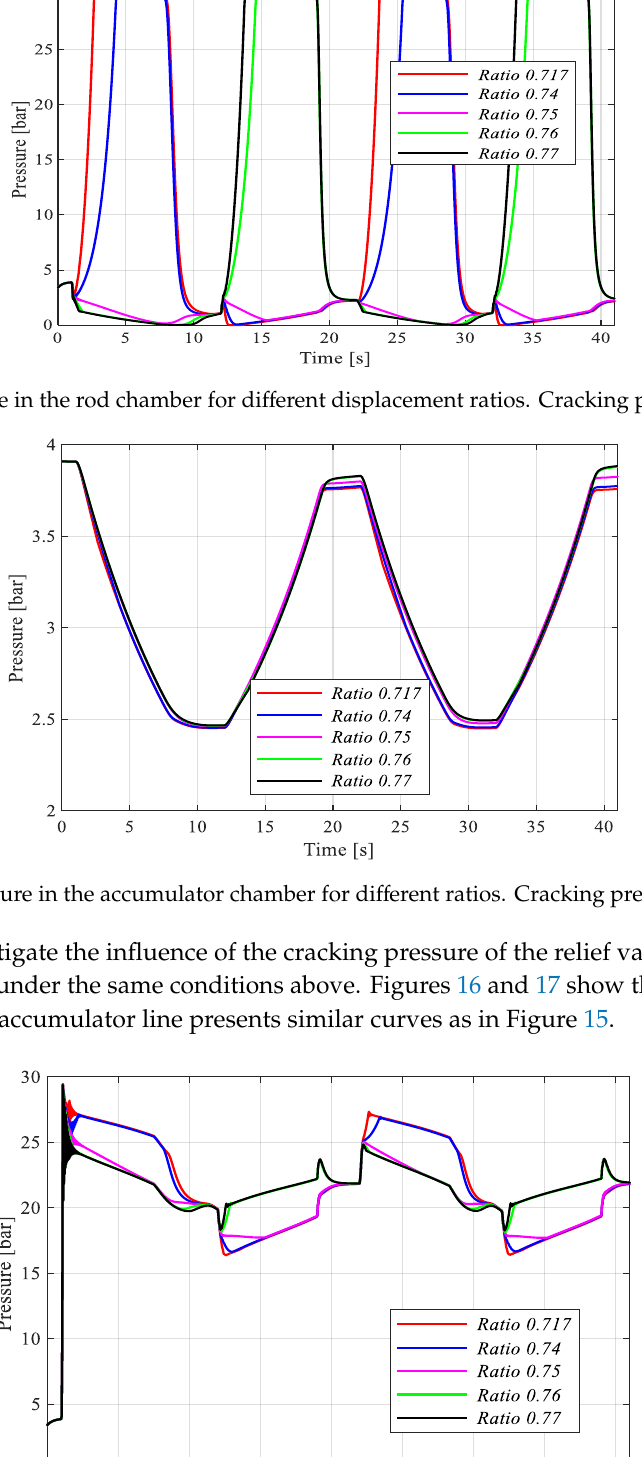
Figure 13. Pressure in the piston head chamber for different displacement ratios. Cracking pressure = 30 bar.